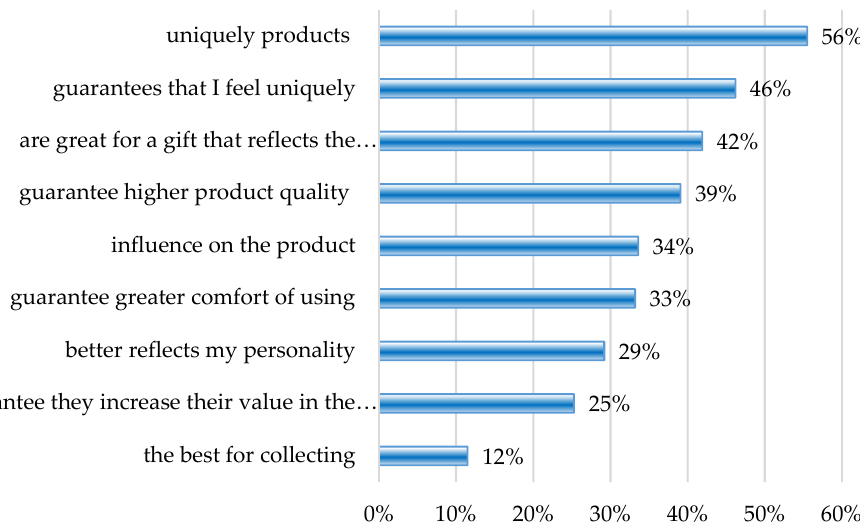
Figure 6. Main reasons for purchasing personalized products. Source: own study.